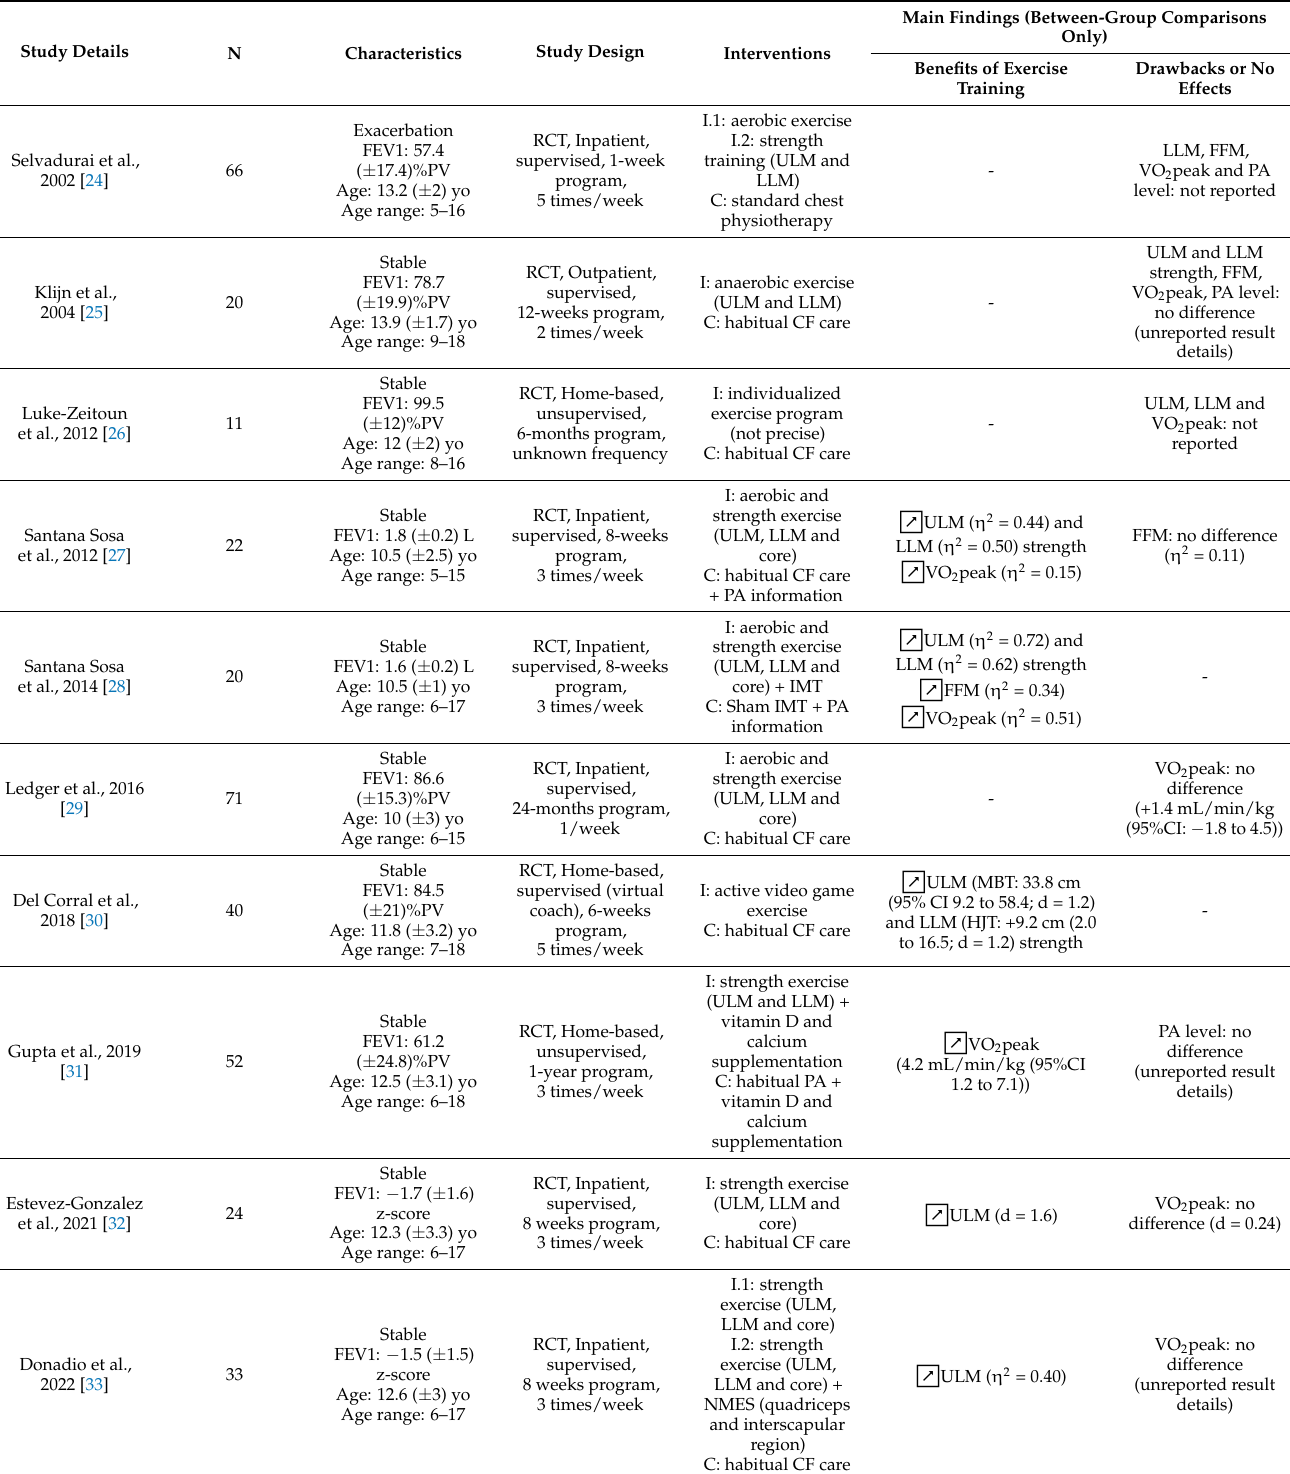
Table 1. Study details and results.